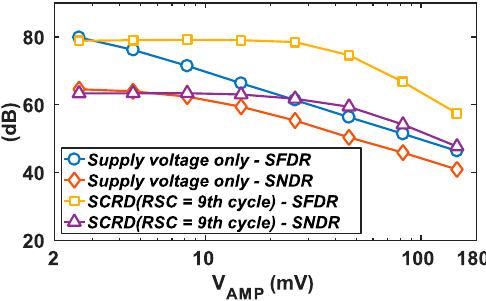
Figure 20. The measurement setup to observe the effect of the supply fluctuation on the dynamic performance of the SAR ADC.